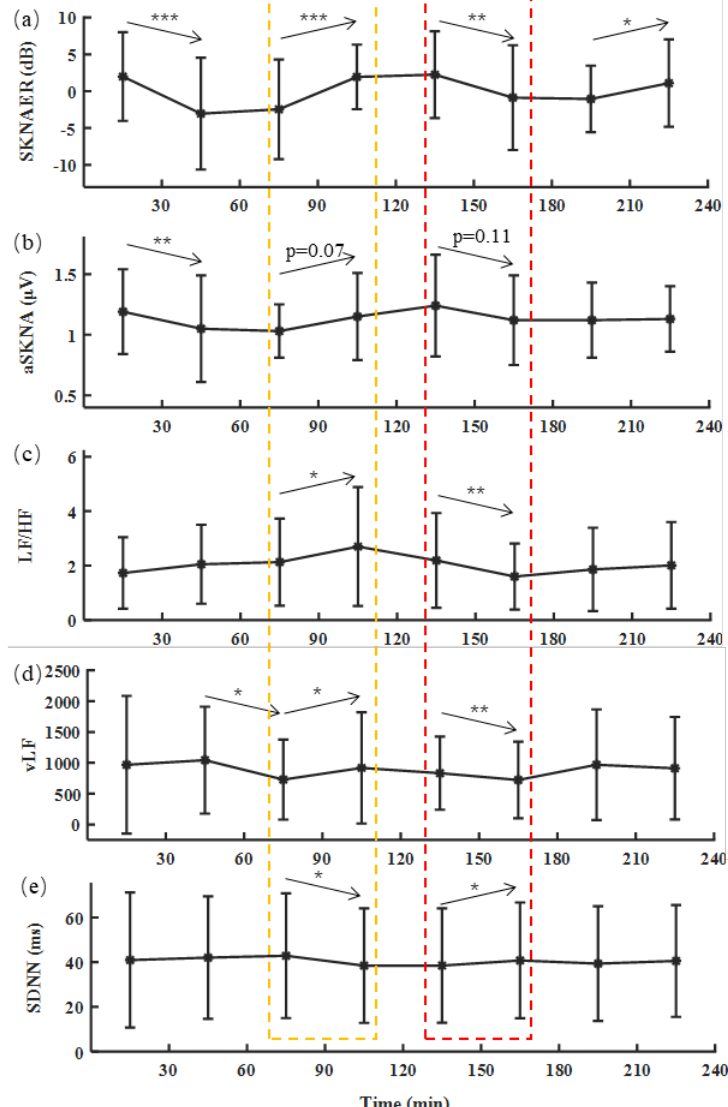
Figure 6. ( a – e ) The trend of the SKNA and HRV features in the twenty patients during four − hour hemodialysis. * p < 0.05, ** p < 0.01, *** p < hemodialysis. * p < 0.05, ** p < 0.01, *** p < 0.001.